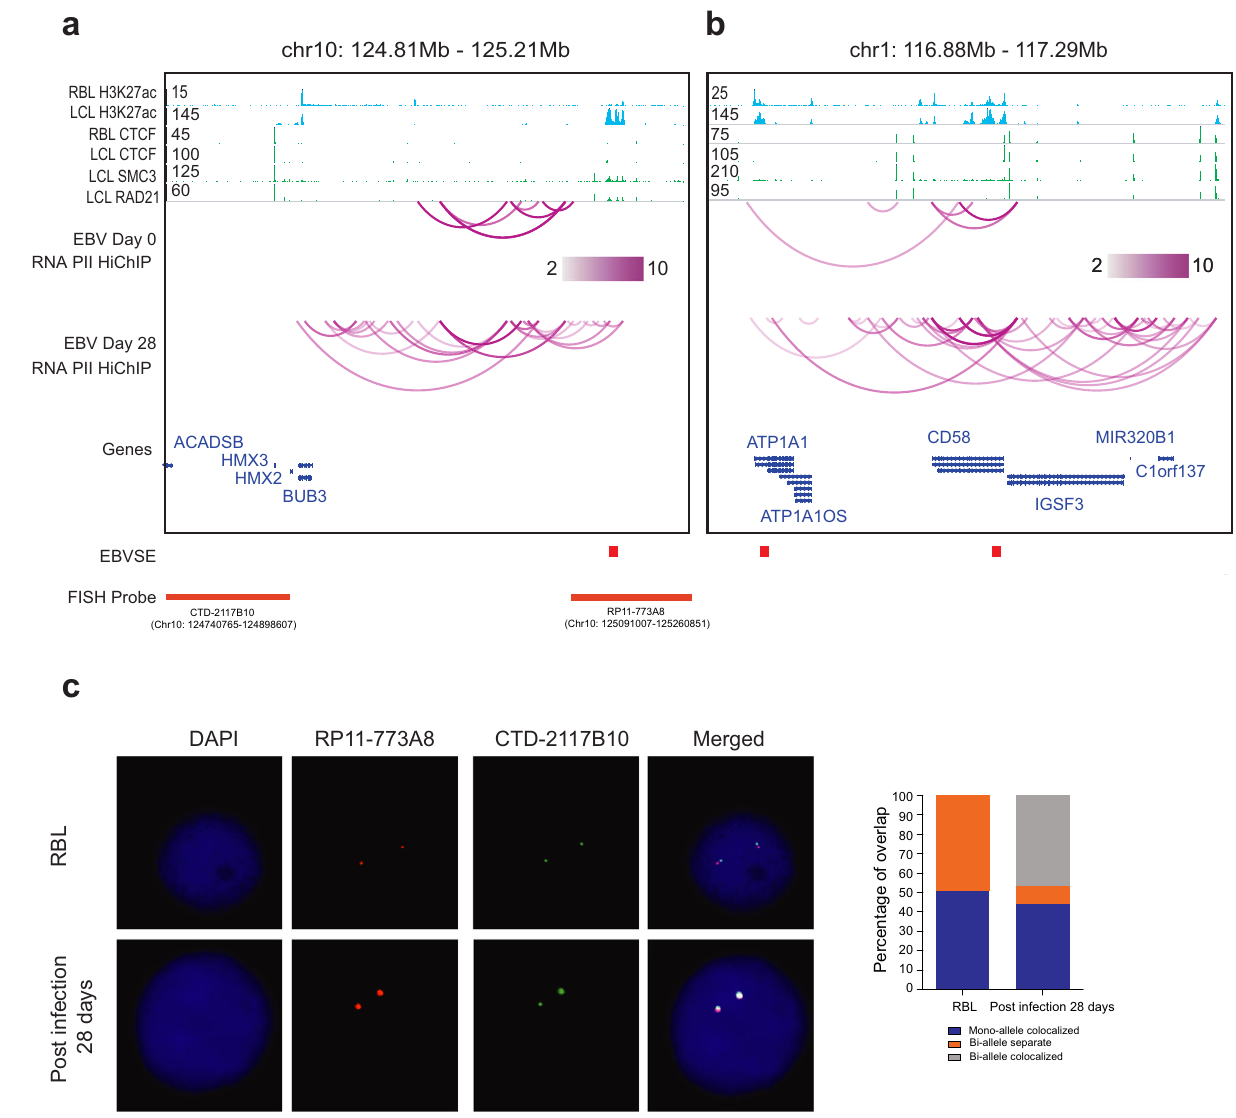
Fig. 4 | ESEs and their direct target interactions in RBL to LCL time course. a RBLs (day0)weretransformed into LCLs (day28)in a time course experiment in replicates. ESE linkages to their direct genes were evaluated by POLR2A HiChIP. Each magenta line represents a genomic interaction. HiChIP links with fi lter threshold >2 are shown. HiChIP loops in RBLs and LCLs at a. ATP1A1 and CD58, b BUB3.RBLandLCLH3K27ac,CTCFandLCLRAD21,SMC3ChIP-seqtracksarealso